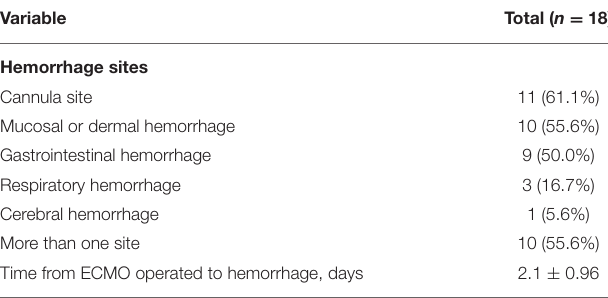
TABLE 9 | Hemorrhage sites and time from ECMO initiation to hemorrhage.